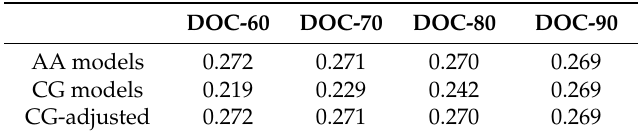
Table 1. Interface cohesive energy of CNT/epoxy nanocomposites using the AA and CG